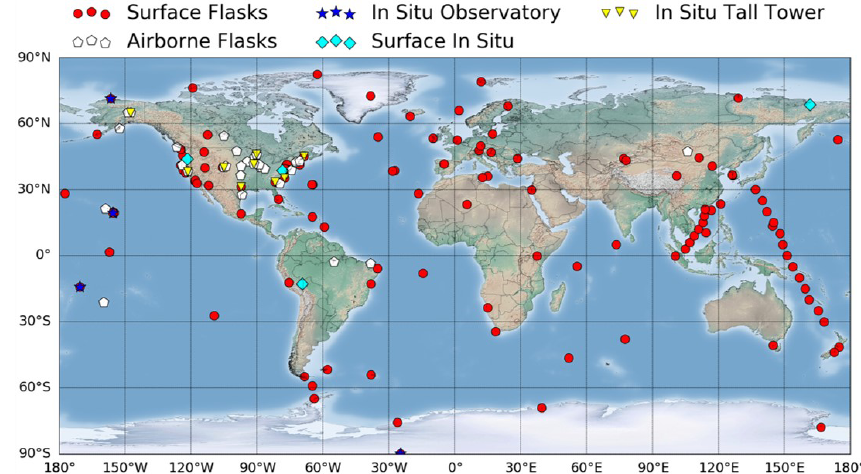
Figure 2. Global GHG monitoring network coordinated by NOAA and WMO. Geolocations of all sites are listed in Table S1 in the Supple- ment. Base map of this figure is from the Basemap package of